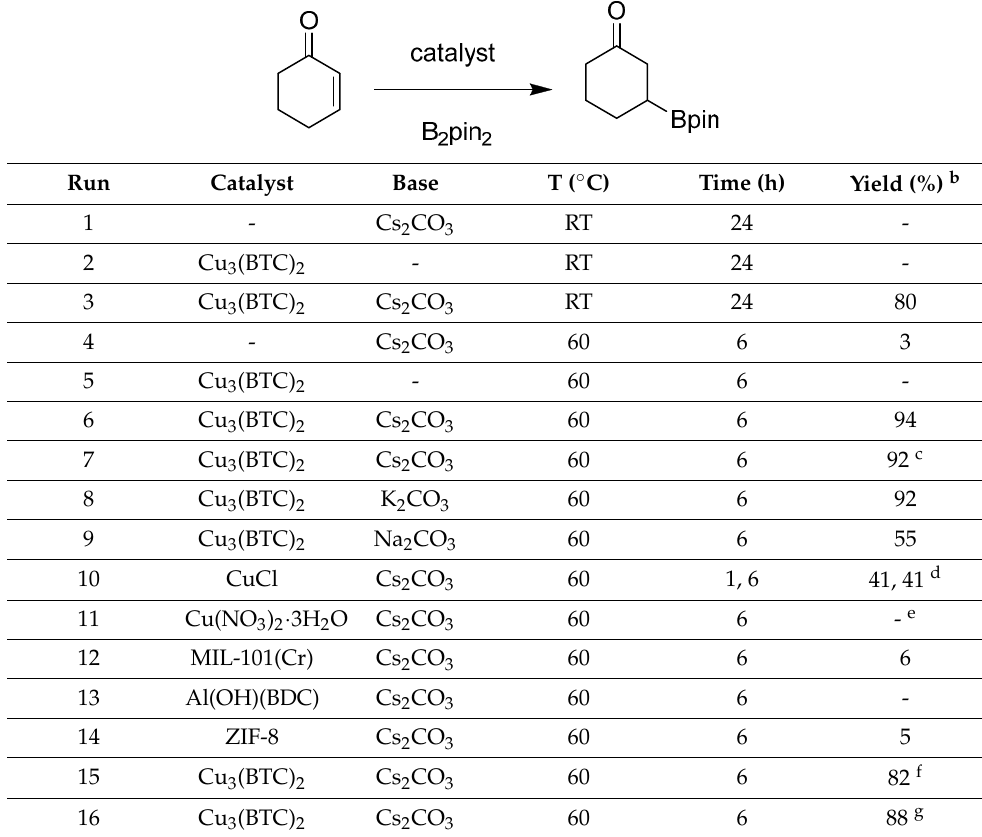
2 pin 2 under various reaction conditions a .